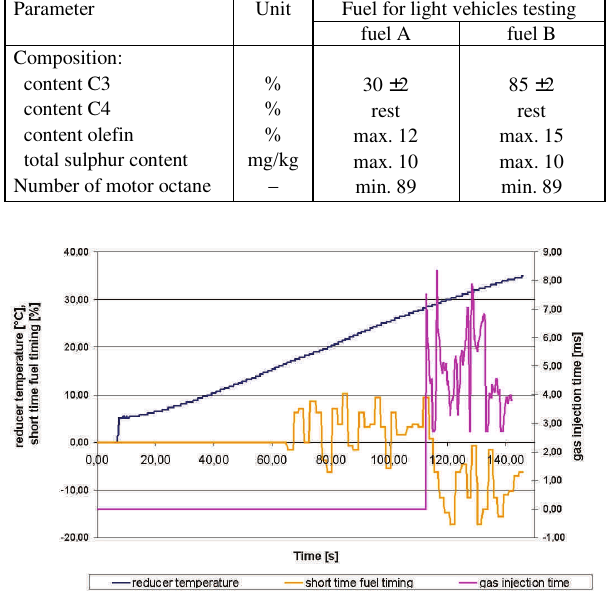
Fig. 3. Parameters related to fuel